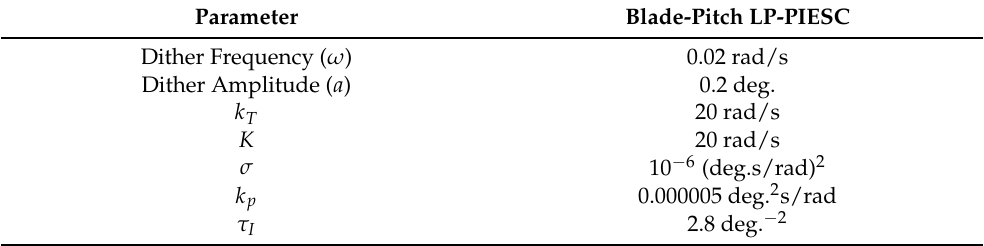
Figure 24. Bode Plot of input dynamics, and the dither frequency. Table 6. LP-PIESC Parameters of NREL 5 MW Region 2 blade pitch controller. See Equations